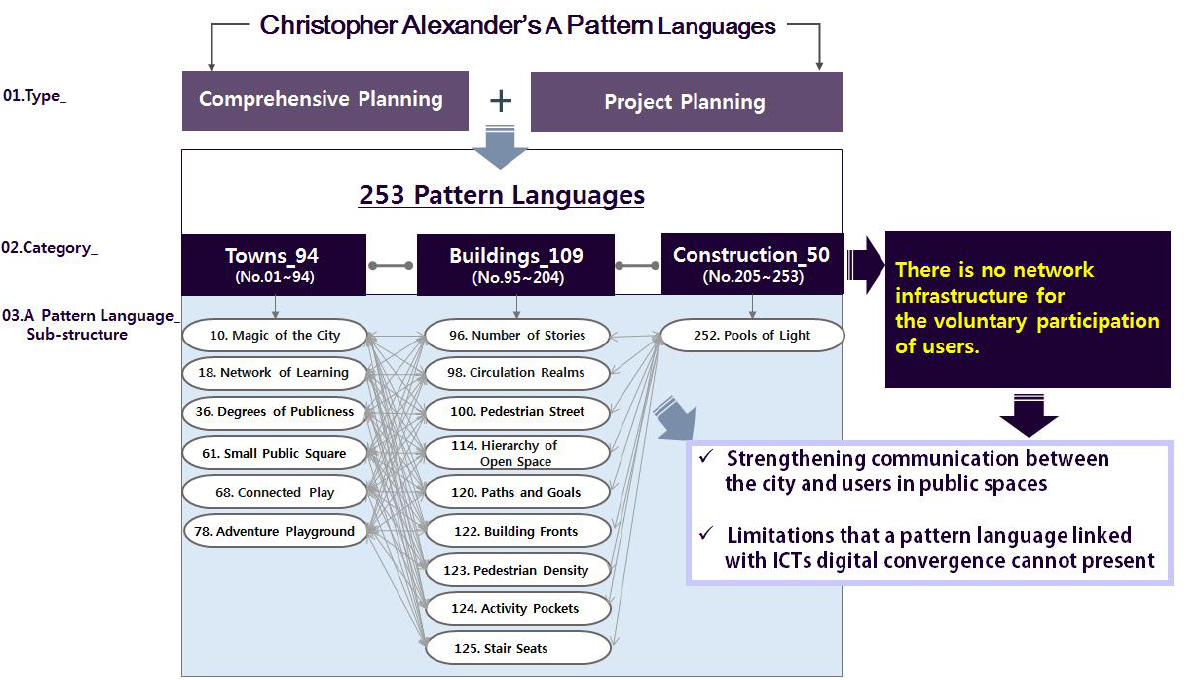
Figure 1. A total of 16 out of 253 pattern languages were derived for strengthening communication between the city and users in public spaces.